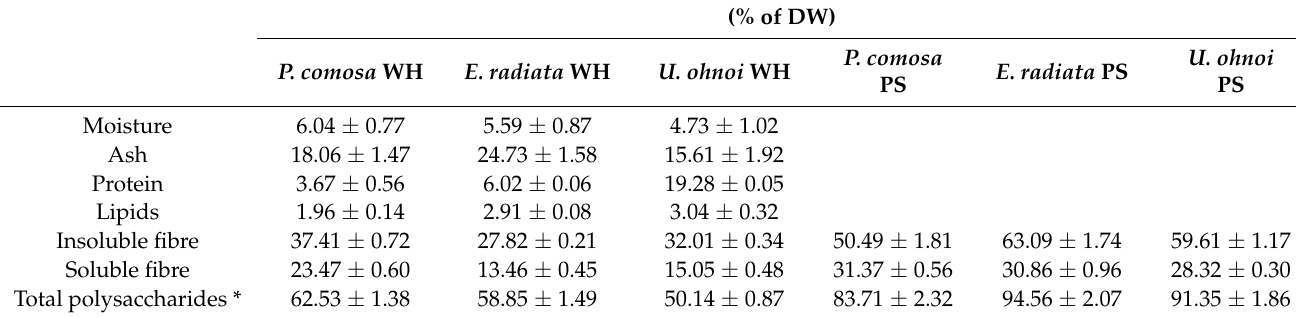
Table 1. Proximate composition of WH seaweeds and PS and PP extracts (percentage ± SD). (% of DW)